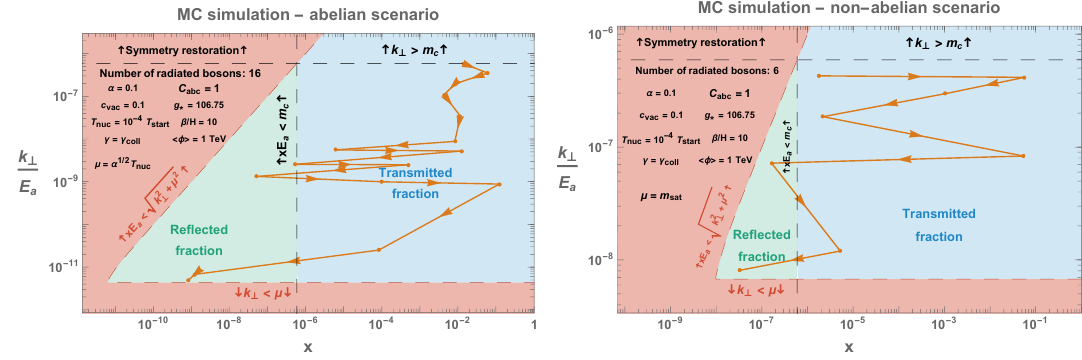
Figure 5 . Trajectory in the phase space ( x, k perp ) (also called Lund plane, e.g. [93]) for two given Monte-Carlo simulations. We set T nuc /T start = 10 − 4 , α ’ 1 / 10 and h φ i = 1 TeV , which imply m c,h /E a ’ 6 × 10 − 7 and γ ’ 2 × 10 10 . Left: we set the IR cut-off to the thermal mass µ = α 1 / 2 T nuc , cf. eq. (3.41), which leads to µ/m c,h ’ 7 × 10 − 6 . Right: we set the IR cut-off to the self-energy of phase-space-saturated boson bath µ = m sat , cf. eq. (3.47), which leads to µ/m c,h ’ 0 . 01 . The orange points linked by arrows are the kinematics variables of the successive emitted bosons generated by the MC algorithm. The ones which pass the threshold E c > m c,h will be able to enter the broken phase ( blue region) while the others will be reflected at the wall boundary ( green region). In the red region, the emission energy is smaller than the thermal mass µ , and therefore emission is kinematically